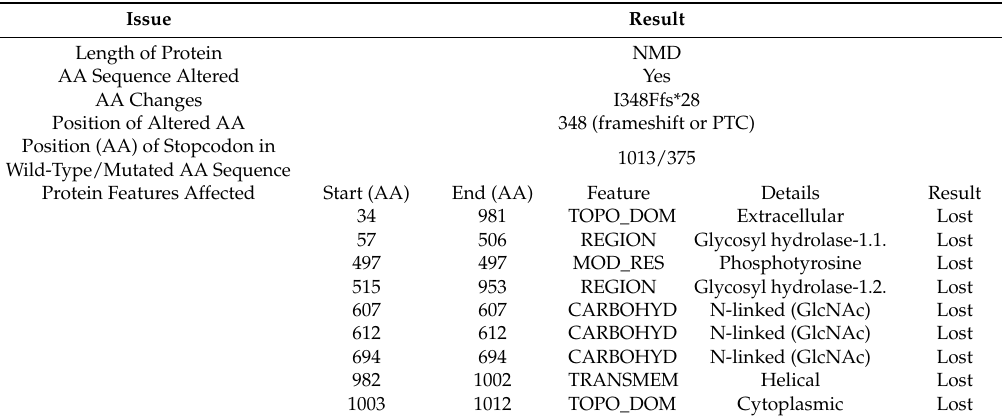
Figure 1. Analysis of deletion variant in the KL gene. ( A ) DNA sequencing of the KL gene revealed deletion of a T at 1041 in exon 2. Up, wild-type control; down, patient with heterozygous deletion. ( B ) CLUSTAL multiple sequence alignment by MUSCLE (Ver. 3.8) of the predicted amino acid sequences of control and patient deletion allele showing the substitution of isoleucine-348 for phenylalanine, the reading frame shift and the appearing of a premature stop codon. ( C ) cDNA sequencing of the region corresponding to exon 2 in PBMCs of the patient showing the permanence of the T. Table 2. Summary of outcomes from the in silico analysis of the impact of c.1041delT variant in KL protein in the Mutation Taster